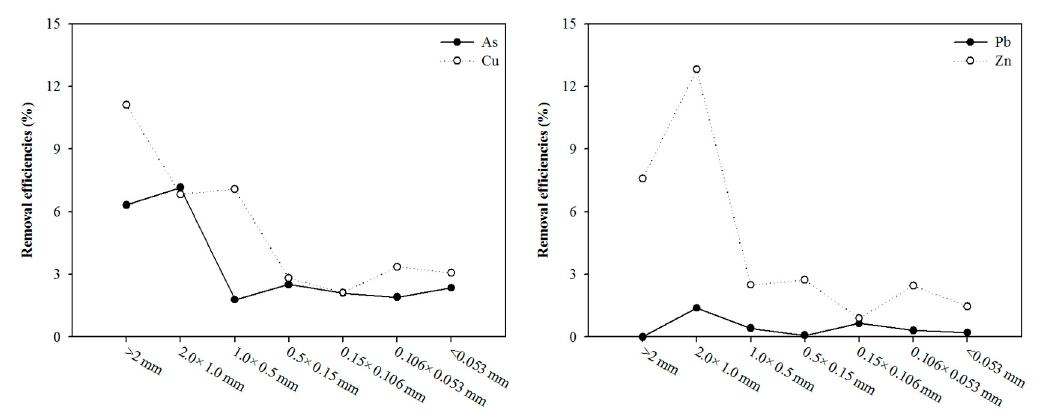
Figure 5. Effect of the size fraction on the extraction of As, Cu, Pb, and Zn from the batch test with water.